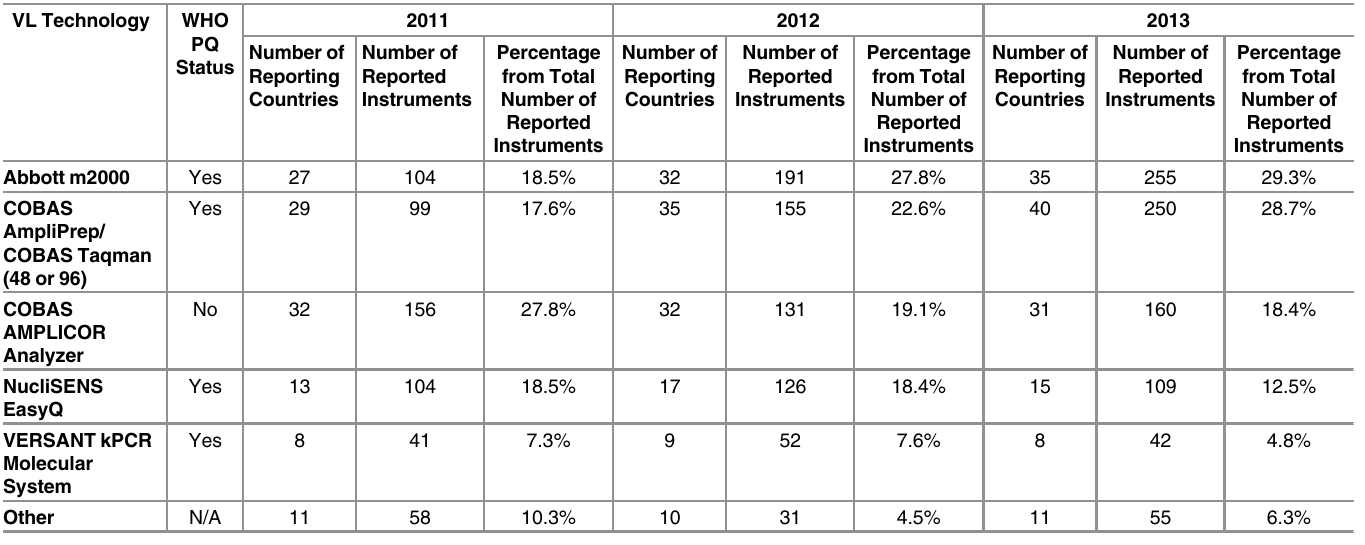
Table 4. Market share by number of branded viral load (VL) technologies in 2011, 2012, and 2013 for all responding